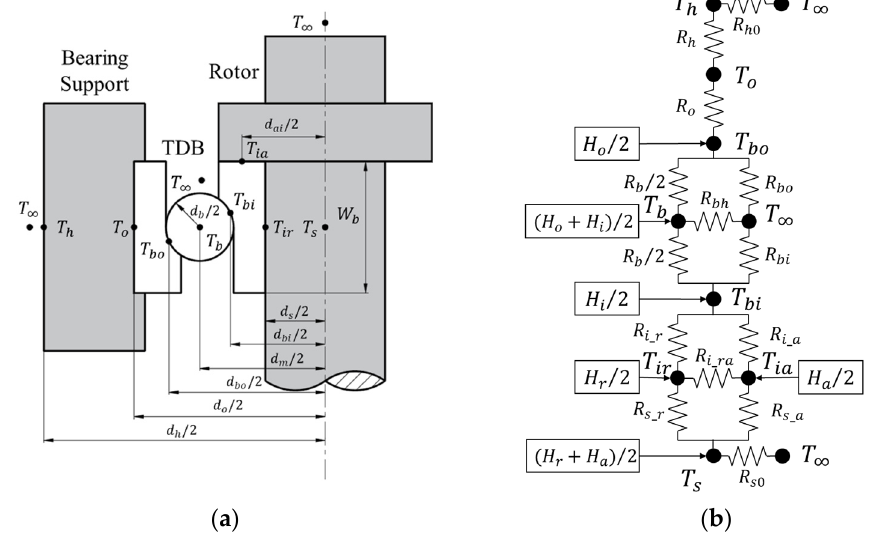
Figure 4. Thermal model of the rotor–TDB system: ( a ) Temperature node model; ( b ) Heat transfer grid model.